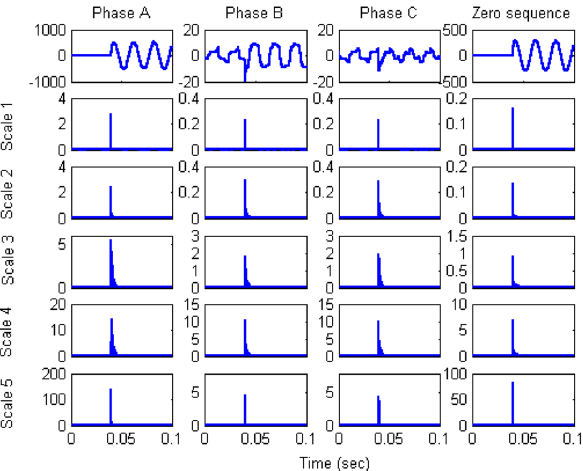
Figure 8. Coefficients of three-phase and zero-sequence differential currents under phase A winding-to- ground fault on low-voltage (secondary) winding at 10% of the length.